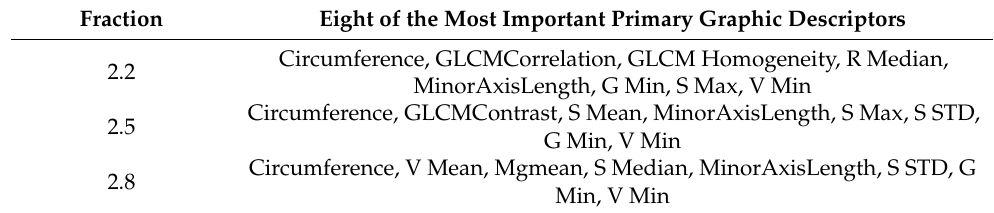
Table 4. Graphical descriptors for 3 fractions (2.2, 2.5, 2.8) of BOJOS variety samples (order by significance level of assignment to the first principal